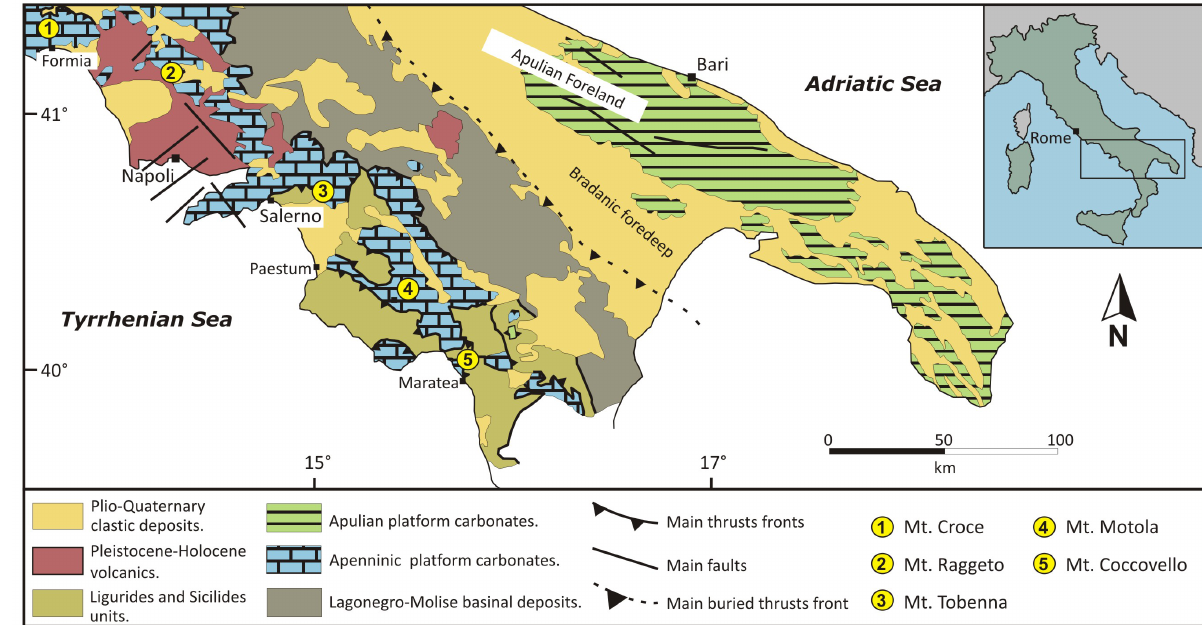
Fig. 2. Schematic geological map of the central-southern Apennines, with location of the studied sections (modified from Bonardi et al.,